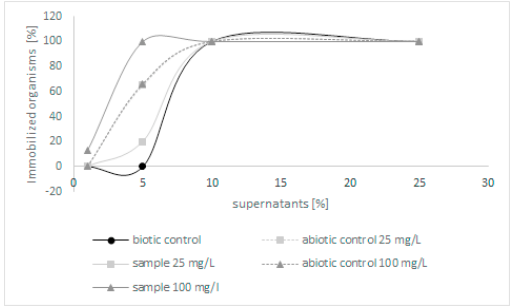
Figure 3. The toxicity of abiotic controls and post-culture liquids obtained after 48 h of incubation of C. lunata IM 4417 with quinoline.